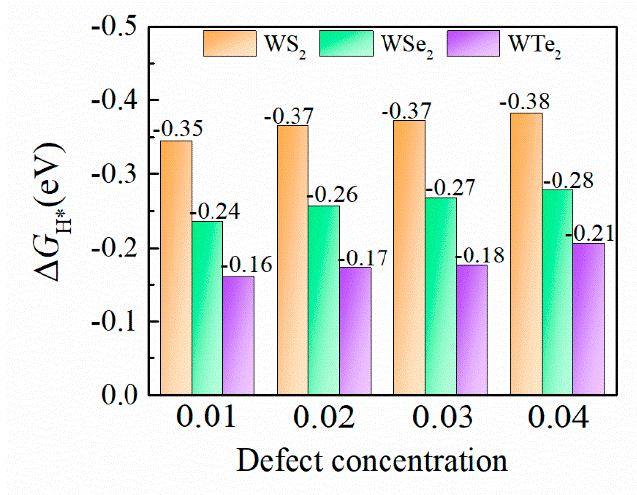
Figure 7. ∆ G H* values of various the P-doping concentrations for the T’-WS 2 , WSe 2 , and WTe 2 Figure 7. Δ G H* values of various the P − doping concentrations for the T’ − WS 2 , WSe 2 , and WTe 2 monolayers.